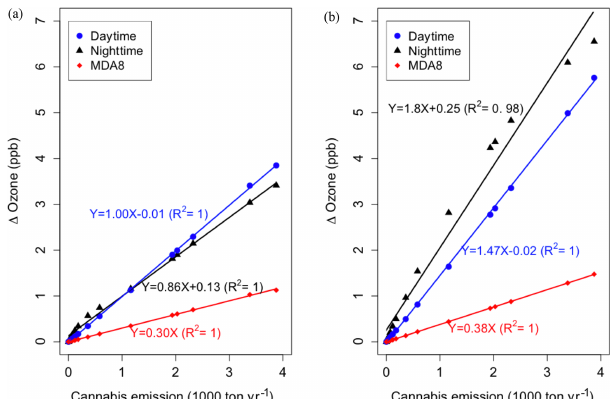
Figure 10. For 18 July during (a) 2011 and (b) 2017 the predicted maximum increase in hourly ozone concentrations during day- time hours (06:00–18:00LST) in blue and nighttime hours (18:00– 06:00LST) in black versus additional terpene emissions in Denver County. Also shown is the response in maximum daily average 8h ozone concentration (MDA8) in